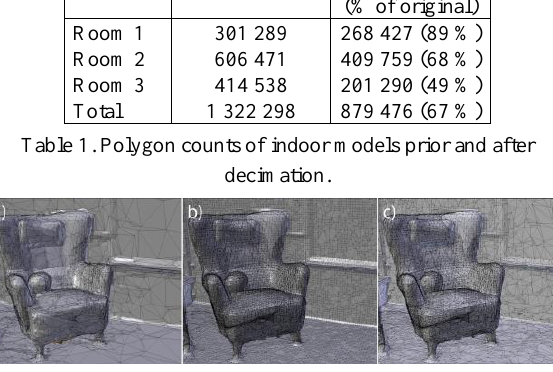
Figure 1. (a) Mesh from a scan project covering all rooms, (b) Mesh from a scan project of a single room, (c) Decimated mesh of single room